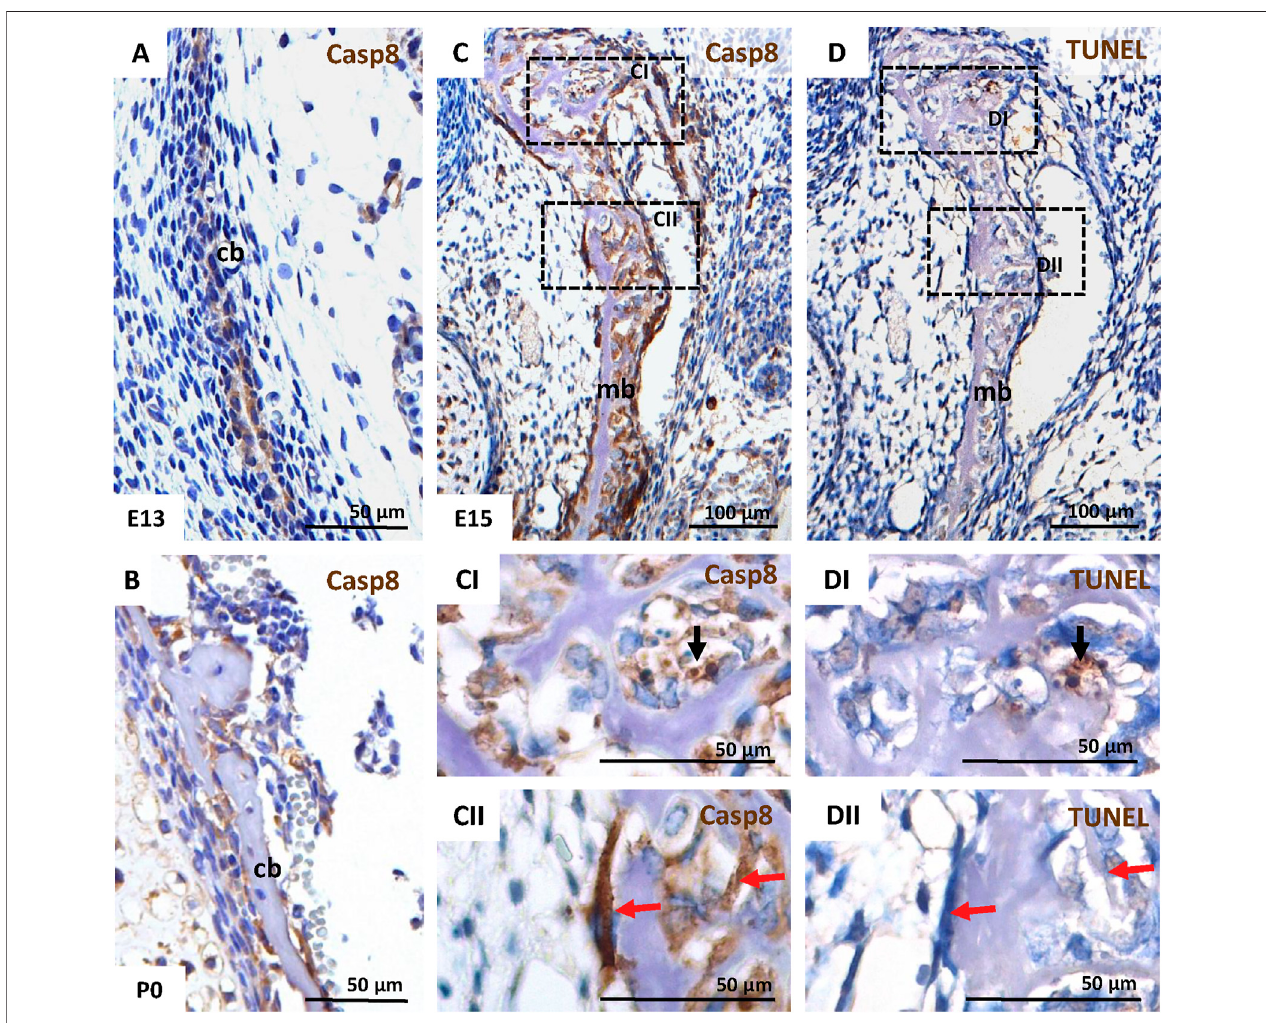
FIGURE1| Activation ofcaspase-8intheintramembranousskullbones inthemouse. IHC ofcaspase-8activationinthecalvarialbone atE13 (A) ,and P0 (B) ,and in mandibular bone at E15 (C,CI,CII) . Apoptotic cells in mandibular bone at E15 were detected using TUNEL assay (D,DI,DII) . Black arrows mark apoptotic cells; red arrows mark non-apoptotic cells in serial sections of mandibular bone. Scale bar = 100 µm for C, D; Scale-bar = 50 µm for A, B, CI, CII, DI, DII. cb calvarial bone, mb mandibular bone.